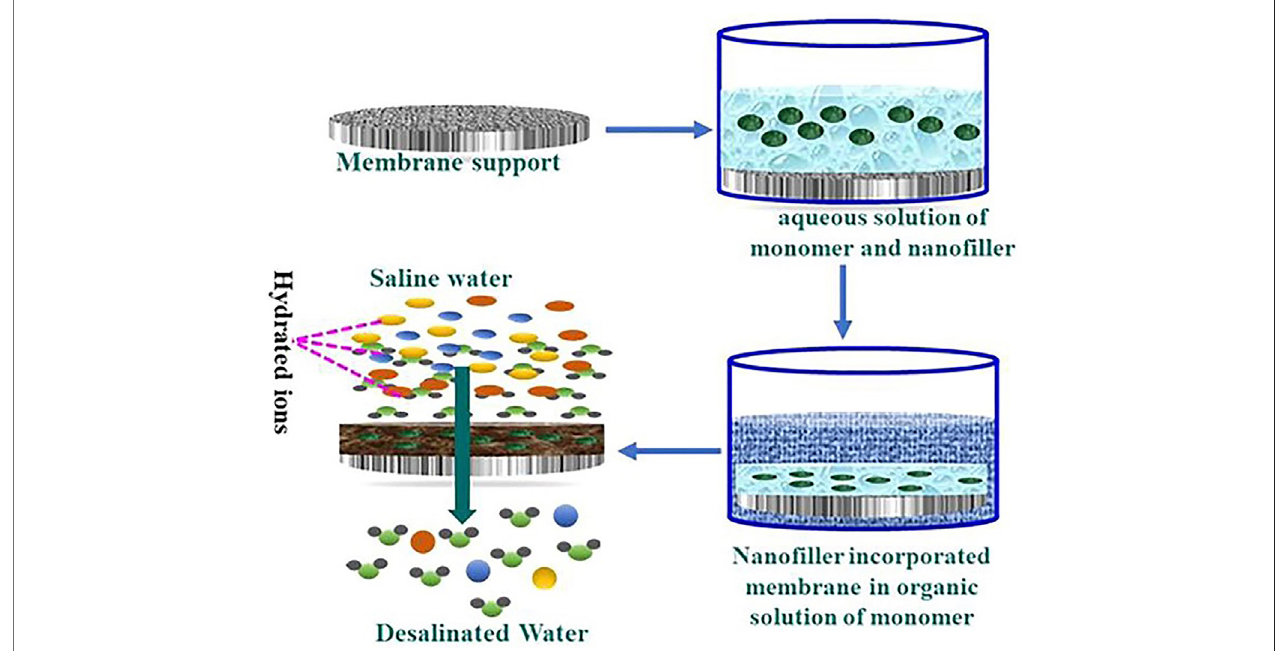
FIGURE 3 | Diagrammatic representation of manufacturing TFN membrane through interfacial polymerization in the presence of nano fi llers (Kumar et al., 2020).